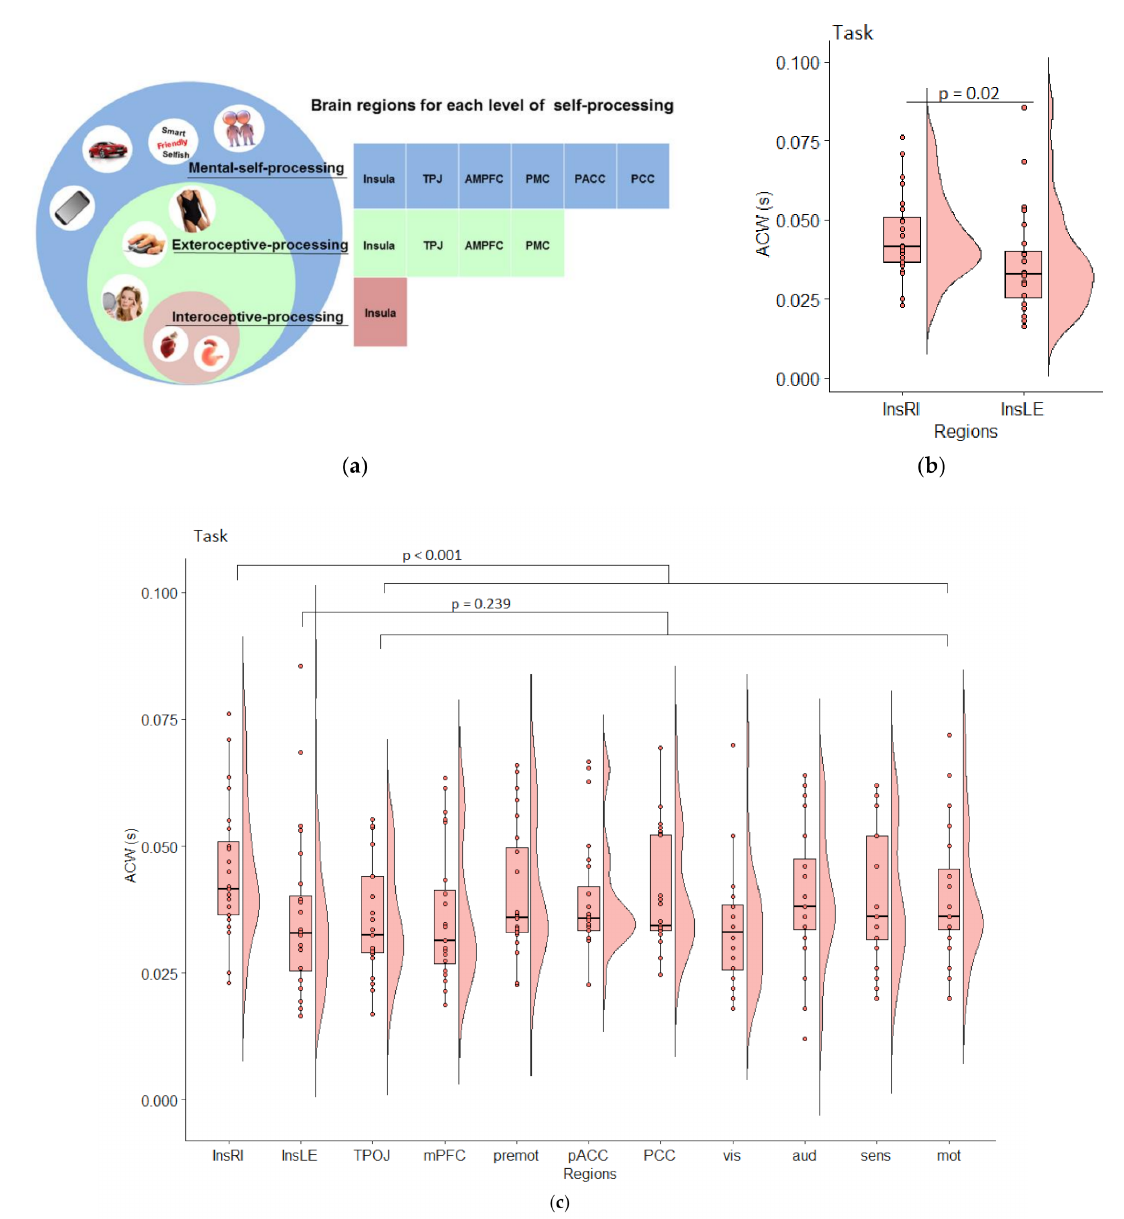
Figure 4. Autocorrelation calculated on the estimated activity per region in task state. ( a ) ROIs for the EEG study. Graph reproduced from Qin et al. (2020) with the kind permission of the authors; ( b ) Comparison of the left and right insula task state.; ( c ) Raincloud plots of ACW in task state in all ROIs. p -values represent Helmert contrasts. Aud = primary auditory cortex, InsLE = left Insula, InsRI = right Insula, mot = primary motor cortex, mPFC = medial prefrontal cortex, pACC = perigenual anterior cingulate cortex, PCC = posterior cingulate cortex, premot = premotor cortex, sens = primary somatosensory cortex, TPOJ = temporo-parieto-occipital junction, vis = primary visual